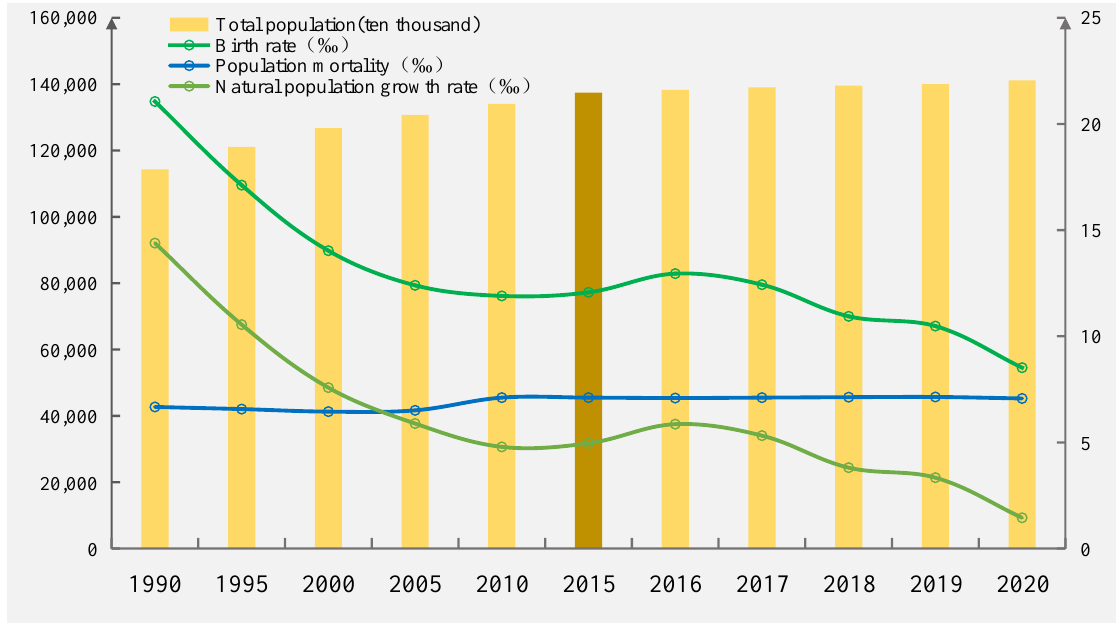
Figure 1. China’s birth rates, death rates, natural growth rates and total population. In August 2021, the Chinese government decided to amend the Population and Family Planning Law to further improve the willingness of childbearing-age individuals to have children. Under the revised Population and Family Planning Law, a couple can have three children. The implementation of China’s three-child policy is conducive to improving